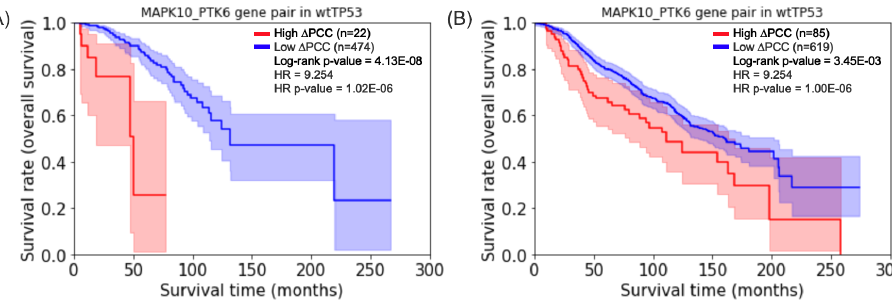
Figure 4. Kaplan–Meier plots for the gene pair MAPK10_PTK6. ( A ) The gene pair for prognosis of survival of wtTP53 in TCGA-BRCA. ( B ) The gene pair for prognosis of survival of wtTP53 in METABRIC.